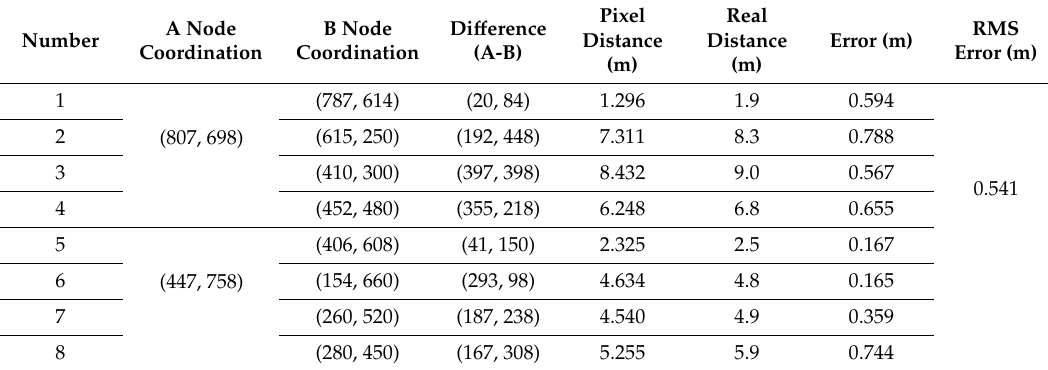
Table 4. RMS error result for real